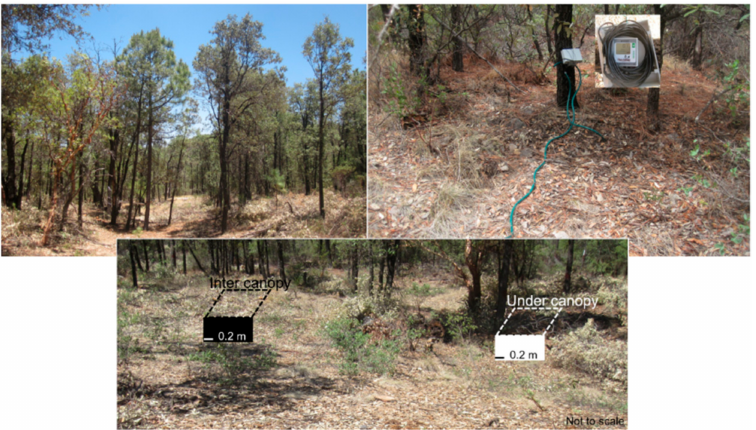
Figure 3. Location of soil moisture sensors inter canopy, and under canopy in an oak-pine forest in Chihuahua,